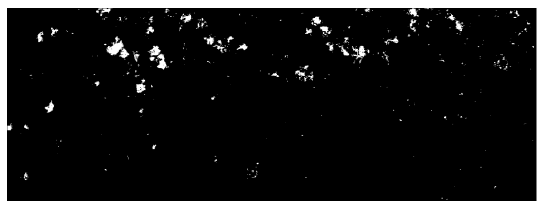
Figure 6. Comparison of four threshold segmentation results in VEG grayscale image (from top to bottom: Otsu method, Kittler method, Bernsen method and Niblack method).